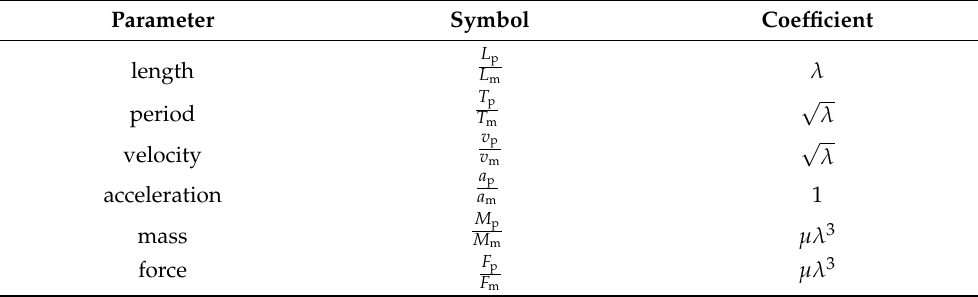
Table 2. Similarity principle scale coefficient of physical quantities of prototype and model. Parameter Symbol Coefficient length period